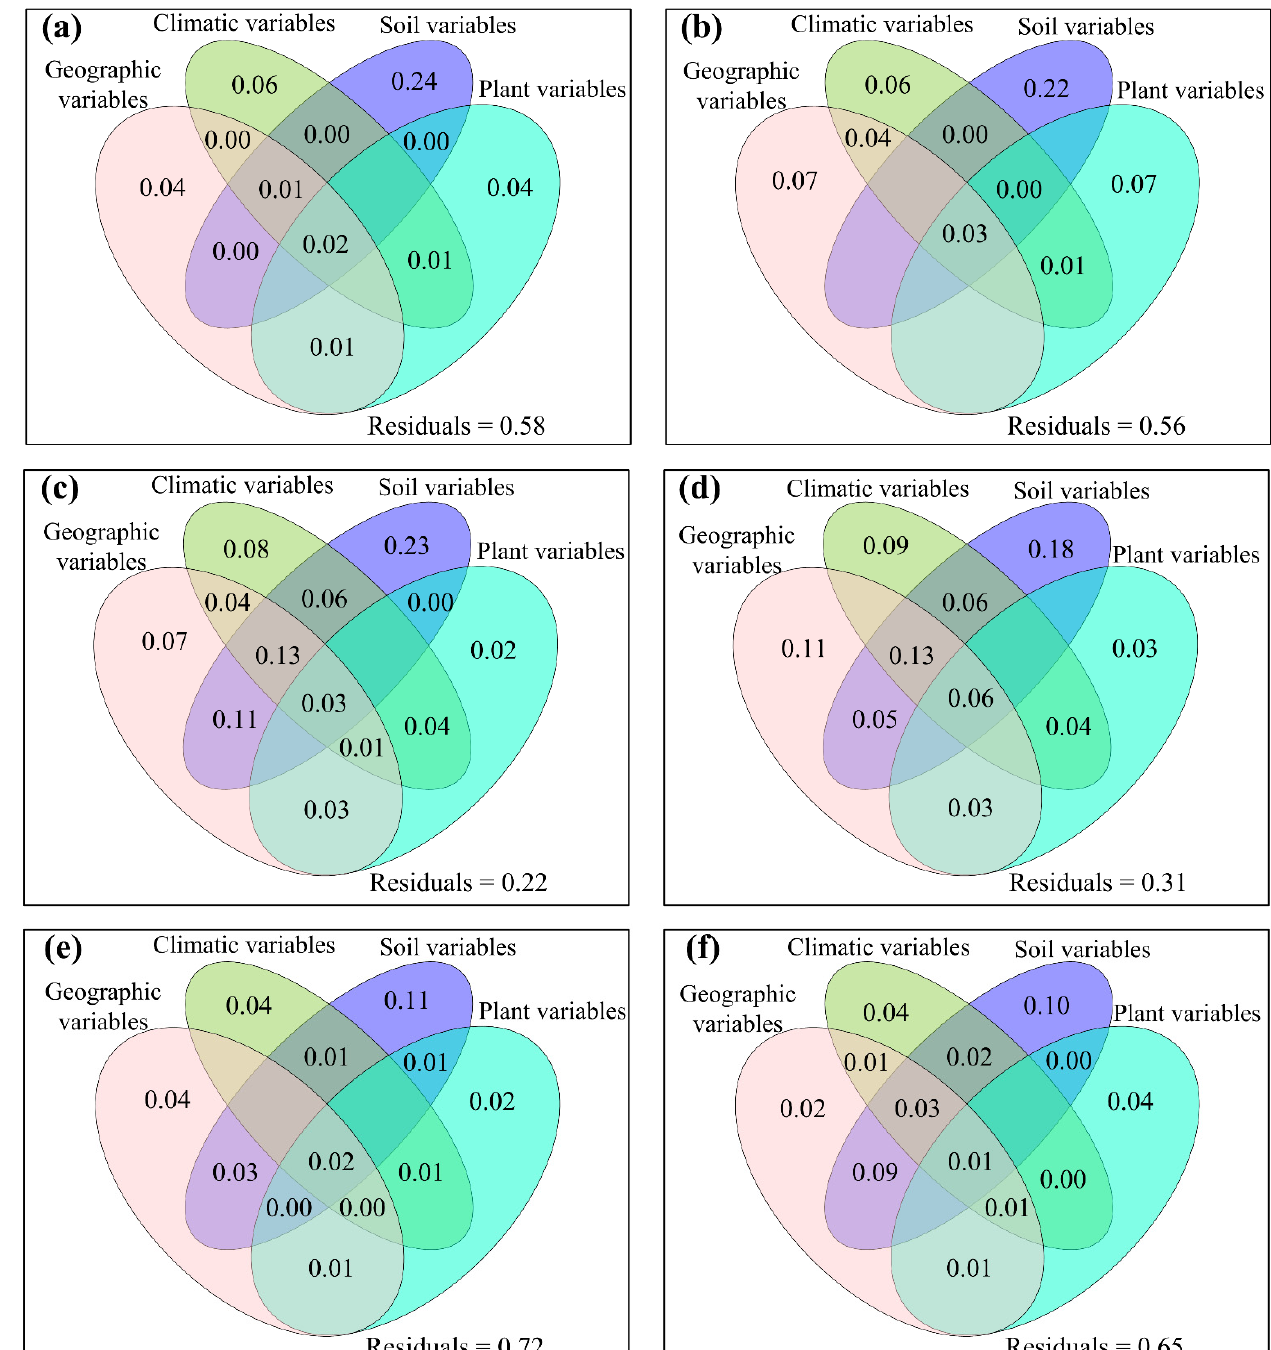
Figure 8. The mutual as well as excluded impacts of geographic variables, climatic variables, soil variables and plant variables on ( a , b ) guild numbers, ( c , d ) Chao1 f , ( e , f ) ACE f , ( g , h ) Shannon f and